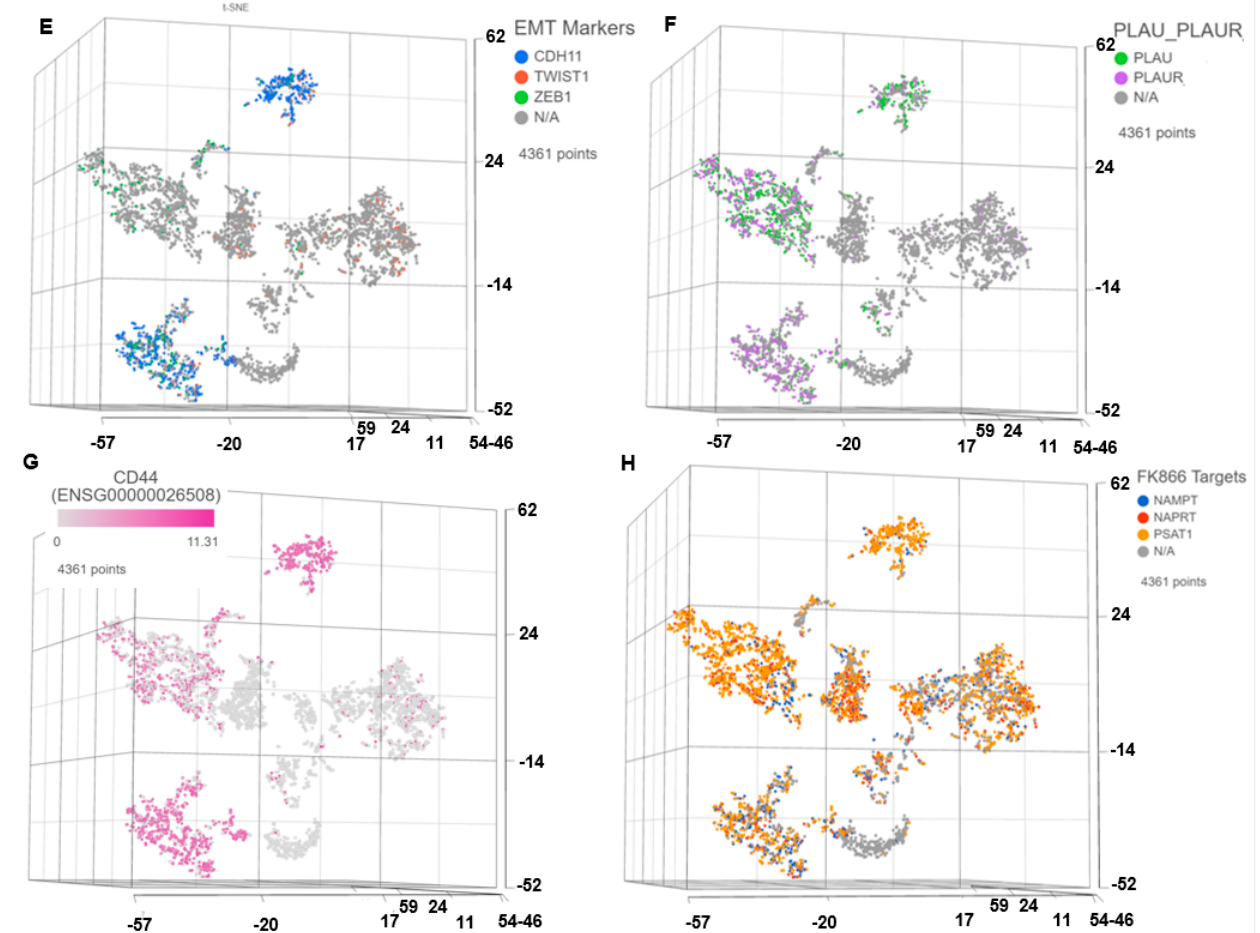
Figure 1. Single-cell transcriptomics identifies signatures of epithelial to mesenchymal transition (EMT) and stemness in metastatic prostate cancer cells. Single-cell RNA sequencing using the Droplet sequencing method (10X Genomics) was performed on the PCa cell lines 22Rv1, LnCAP, DU145, PC3, and PC3M. t-distributed stochastic neighbor embedding (tSNE) plots showing the comparison between the single-cell clusters representing ( A ) All cell lines; ( B ) AR status; Expression of mesenchymal markers involved in EMT transdifferentiation, including the ( C ) Vimentin (VIM); ( D ) N-Cadherin (CDH1), Fibronectin (FN1), S100A4, Snail (SNAI1), Slug (SNAI2); other major EMT markers ( E ) CDH11, TWIST1, ZEB1. Expression of genes potentially involved in Cancer stemness ( F ) Urokinase-type plasminogen activator (PLAU) and Urokinase-type plasminogen activator receptor (PLAUR); ( G ) CD44; FK866 target pathway genes ( H ) Nicotinamide phosphoribosyltransferase (NAMPT), Nicotinate Phosphoribosyltransferase (NAPRT), and Phosphoserine Aminotransferase 1 (PSAT1). Each dot represents a single cell. Contaminated (doublet) cells were not included.